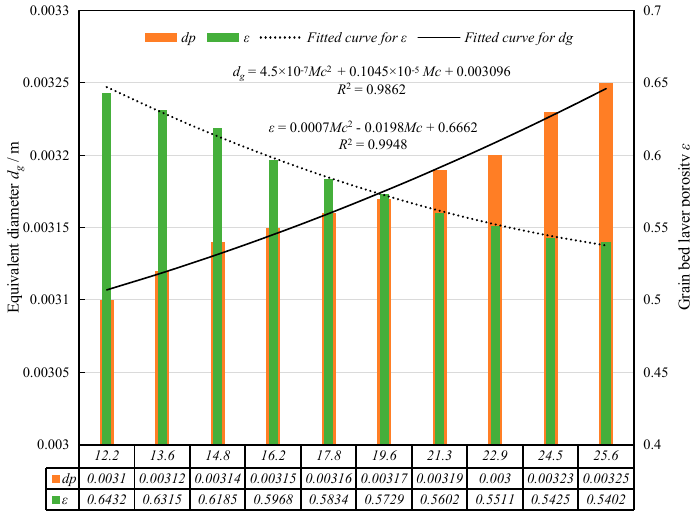
Figure 2. The variations of the d g and ε with Mc .